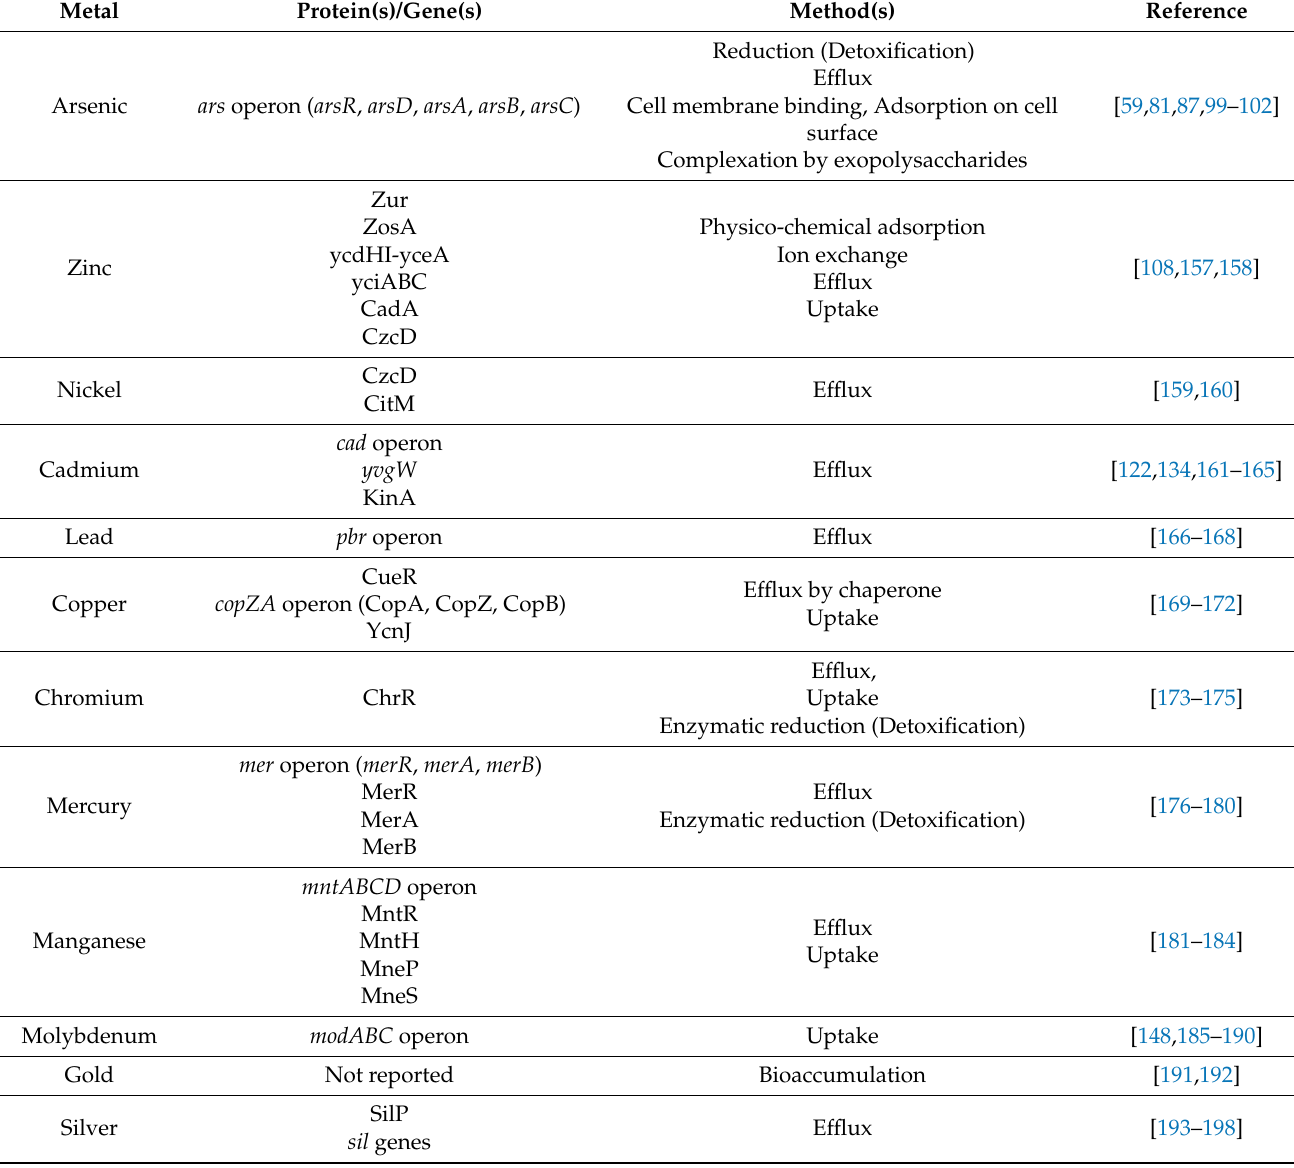
Table 2. The proteins, operons, and methods of removal employed by Bacillus spp. for the bioregulation of heavy